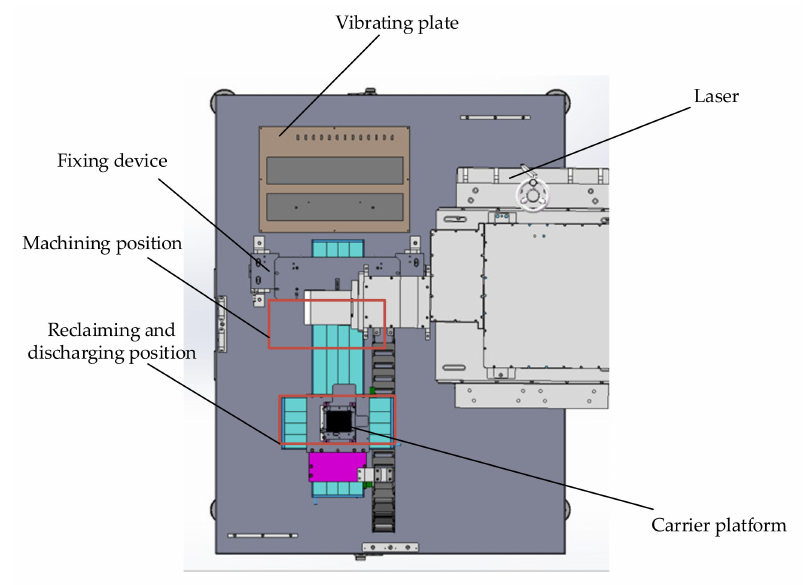
Figure 2. Layout of laser processing system for MCR frequency